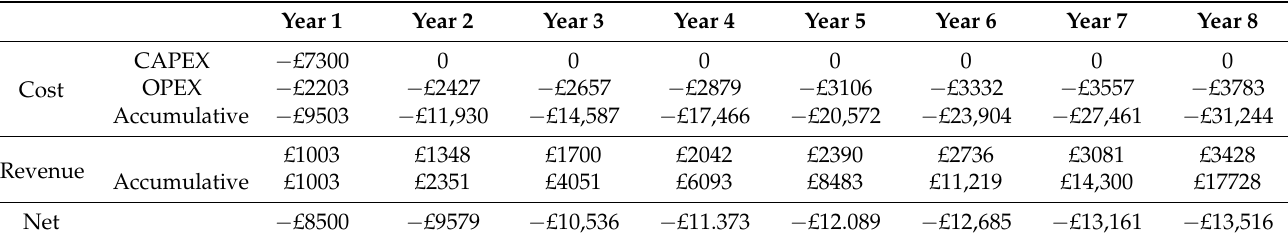
Table 16. Cost and revenue of PCS in County